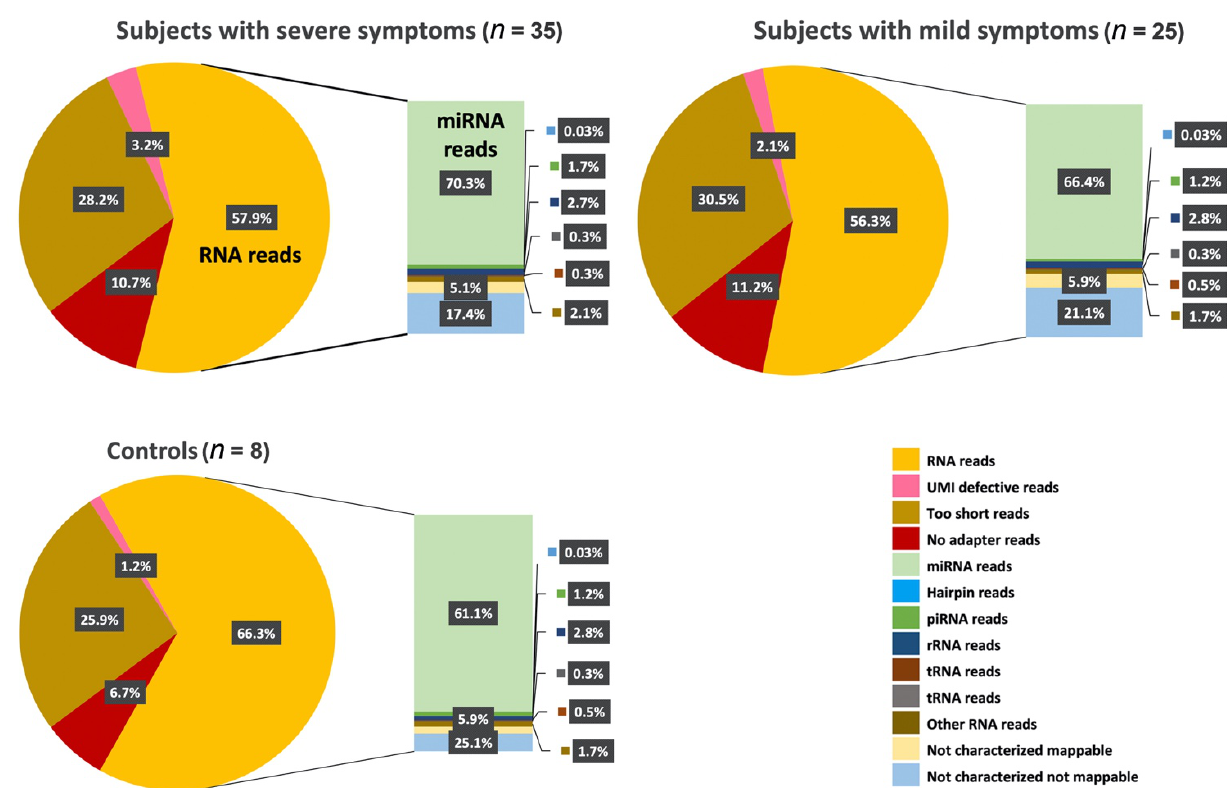
Figure 2. Circulating transcriptome profile analysis on plasma. Pie charts representing the relative abundance of RNA families in the plasma of controls (N = 8) and individuals that manifest severe symptoms of ASD (N = 35) and mild symptoms of ASD (N = 25). The group labeled as “Other RNA” in the pie charts is representative of reads derived from several Gencode annotation categories, such as snoRNAs, YRNAs, etc.